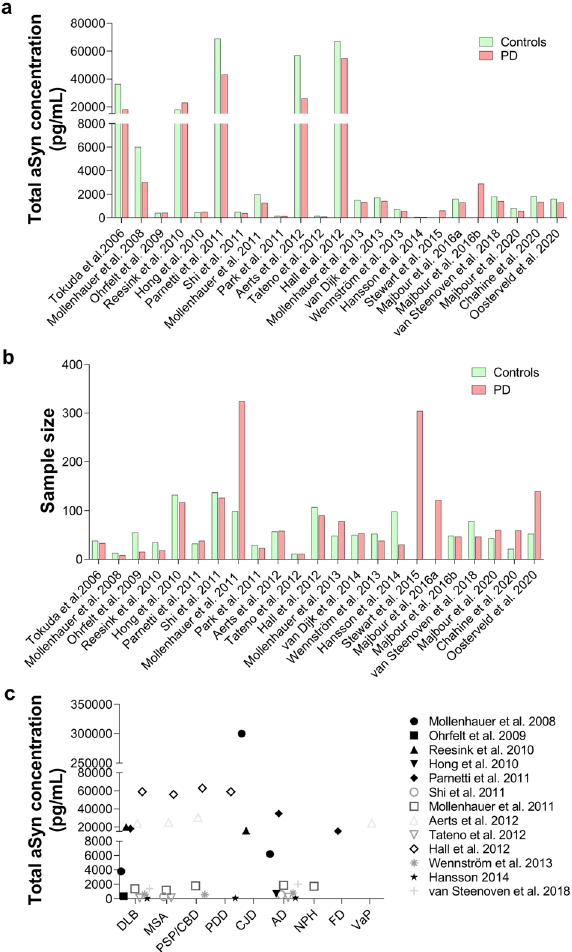
Fig. 3 An overview of previous studies reporting total aSyn levels in CSF of PD, controls and patients suffering from other synucleinopathies (e.g., DLB, MSA, PSP) and tauopathies. a Comparison of CSF levels of total aSyn between PD and controls in different studies. b Sample size of PD and controls used in the studies shown in a. c Variability of CSF levels of total aSyn across other disease-group patients. Each dot in the graph displays the average values of aSyn reported in the respective study. CBD corticobasal degeneration, MCI mild cognitive impairment, VaP vascular parkinsonism, CJD Creutzfeldt – Jakob disease, NPH normal- pressure hydrocephalus, FD frontotemporal The correlation between pS129 aSyn levels and disease severity was also assessed in several studies, which yielded inconsistent results. Wang et al. 50 reported a correlation of decreased pS129 levels with PD severity, which was further corroborated by others 77,78 , suggesting that pS129 in the CSF may serve as a progression biomarker for PD and is associated with different PD clinical phenotypes. However, a study by Majbour et al. 79 did not show any association between pS129 levels and disease severity and progression. Moreover, in a recent study, Majbour et al. reported that the pS129 aSyn levels of PD patients were lower at the 2-year follow-up than at baseline; however, this observed reduction did not display statistical signi fi cance 132 .